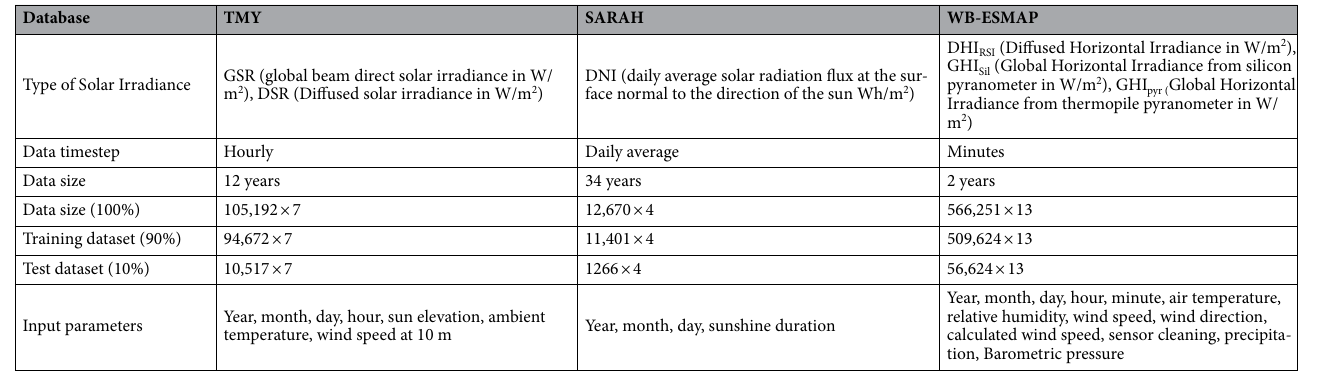
Table 3. Data training and test set